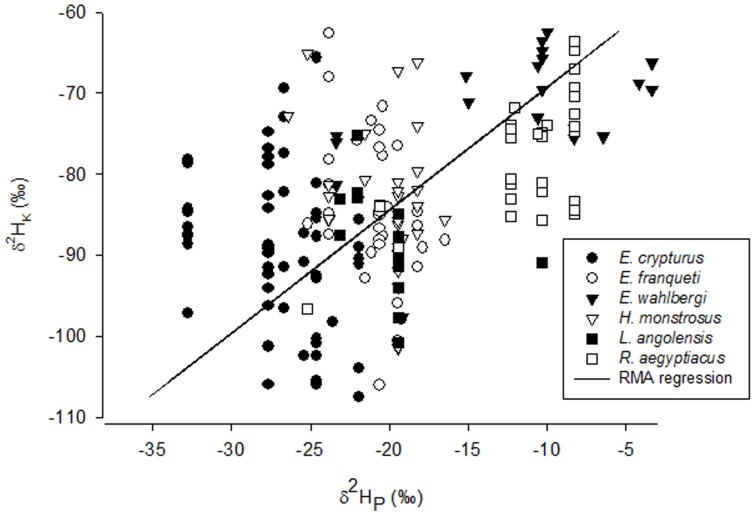
Relationship between δ2HP and δ2HK for non-migratory species (n = 193). δ2HP was obtained from [44].The solid line indicates the RMA regression.